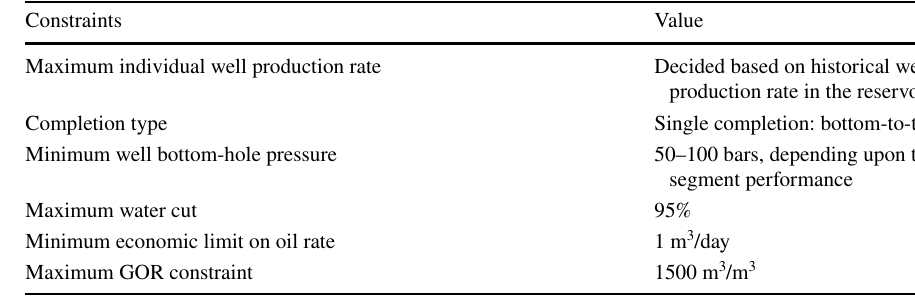
Table 4 Well level constraints for prediction runs